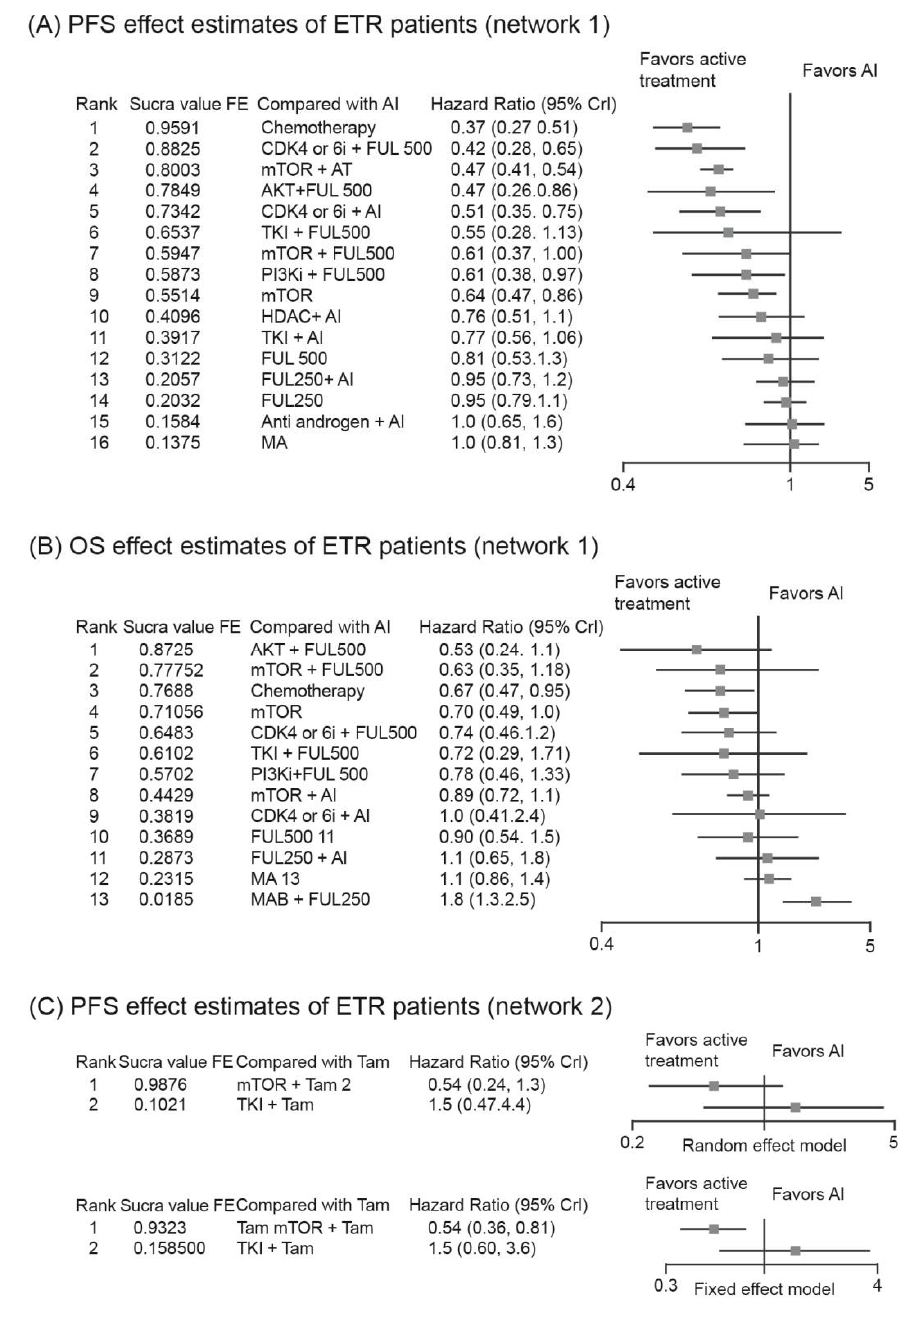
Figure 4. SUCRA values for treatment regimens and relative effect. ( A ) OS effect estimates of ETR patients; ( B ) OS effect estimates of ETR patients (network 1); ( C ) PFS effect estimates of ETR patients (network 2).